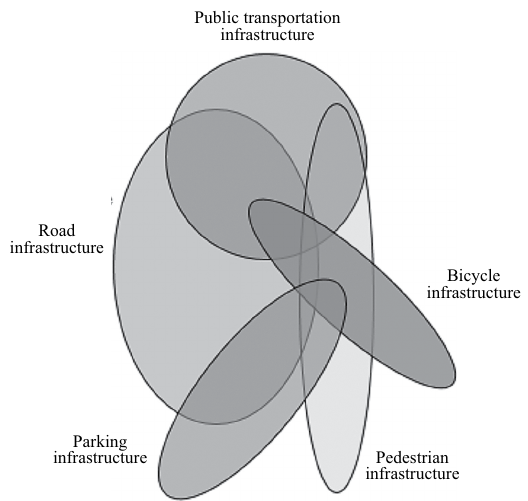
Fig. 1. Connection and proportion of infrastructure elements in passenger transportation network (source: research by the